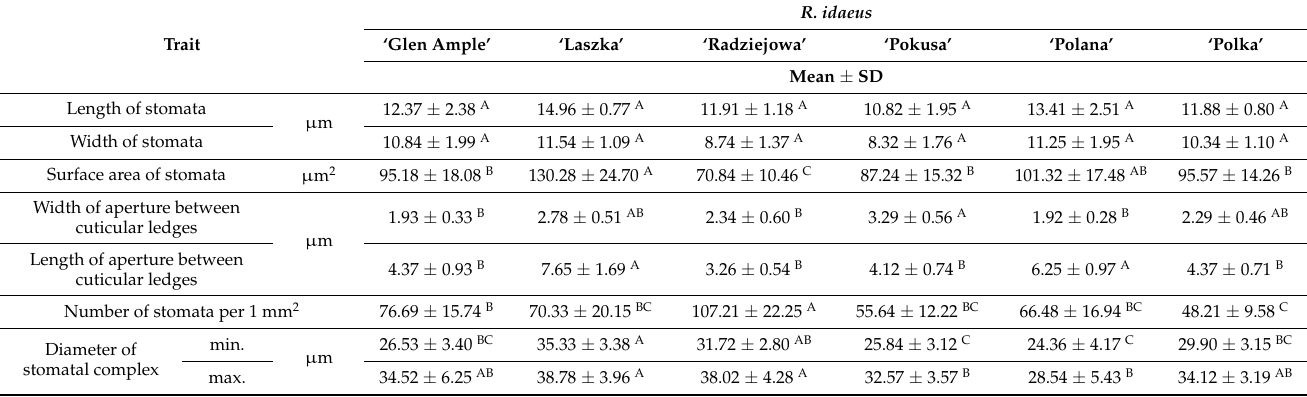
Table 3. Size and number of stomata per unit area and diameter of the stomatal complex on the nectary epidermis surface in the full nectar secretion phase in the R. idaeus